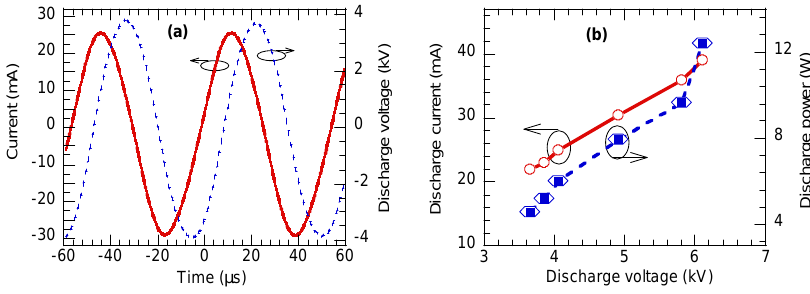
Figure 2. ( a ) Typical discharge power-total current waveform and ( b ) the discharge powers and the peak current dependence of discharge power at a fixed flow